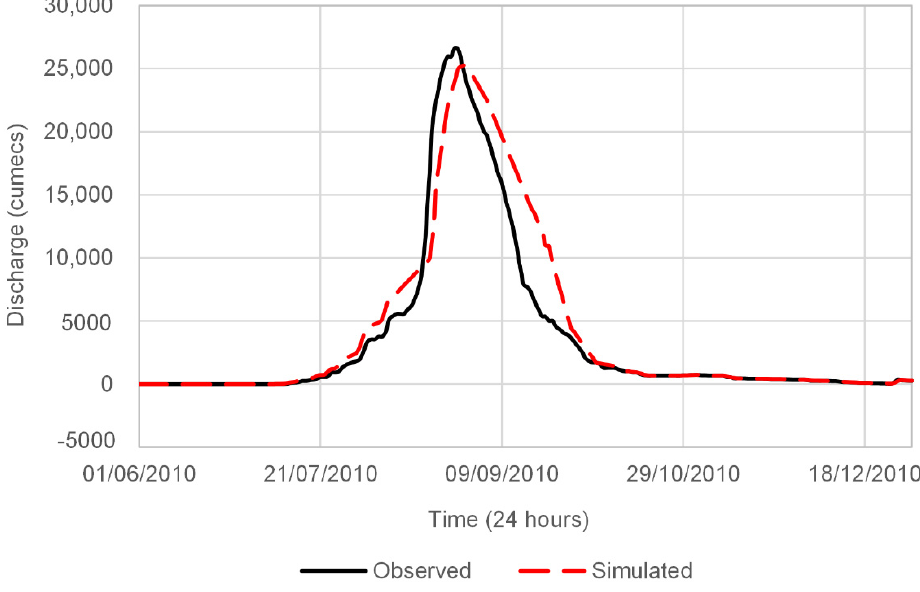
Figure 7. Rating curve based on six-year data from 2008 to 2013 downstream of the Kotri Barrage, Sindh.